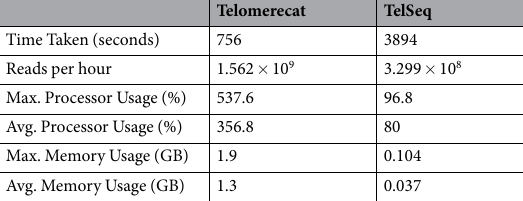
Telomerecat TelSeq